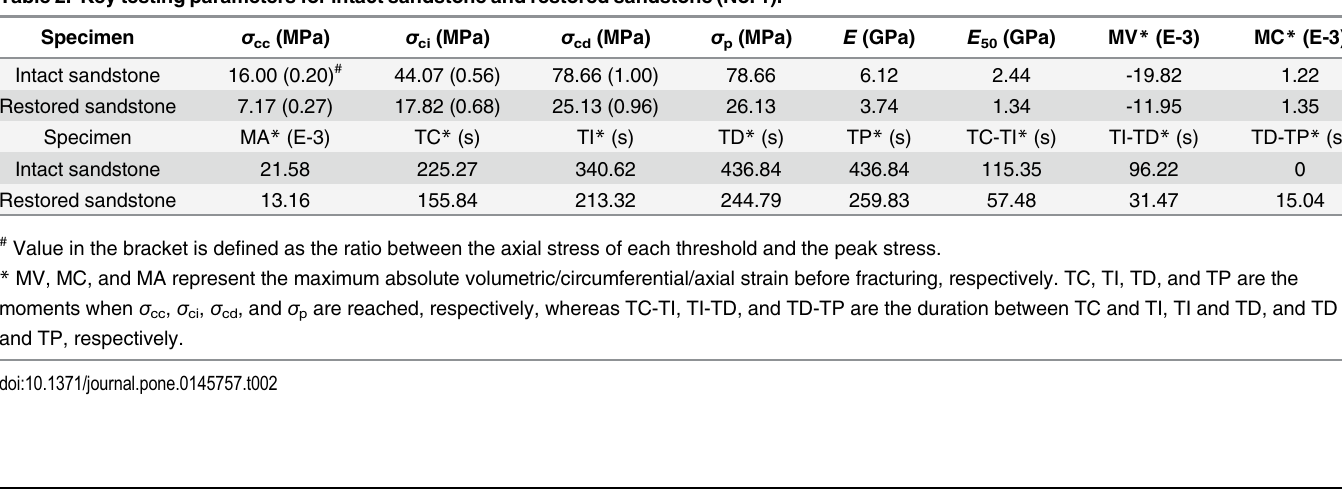
Table 2. Key testing parameters for intact sandstone and restored sandstone (No.